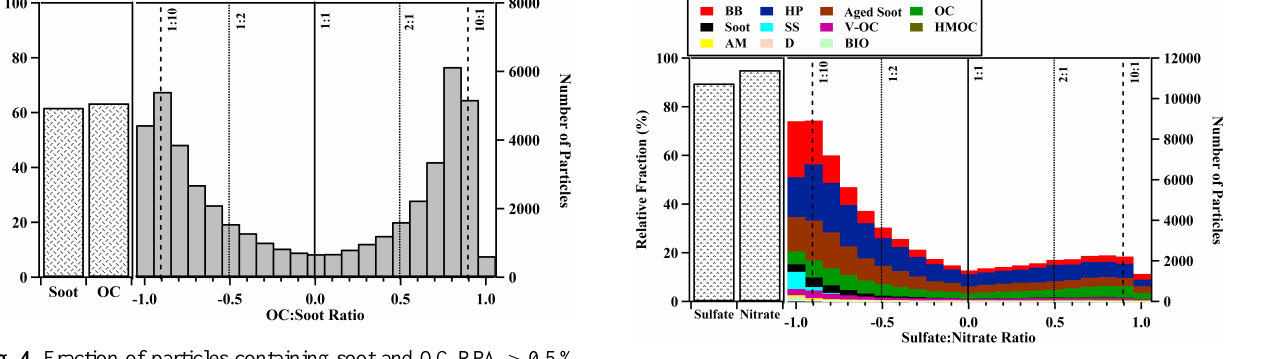
Fig. 5. Fraction of particles containing sulfate and nitrate RPA > 0.5% in southern California (left panel). Sulfate:nitrate ion ratio distributions are shown in (right panel). Values < 0 indicate more nitrate than sulfate and values > 0 indicate more sulfate than nitrate. Ratios representing 1:1, 2:1, and 10:1 are shown by solid, dotted, and dashed lines